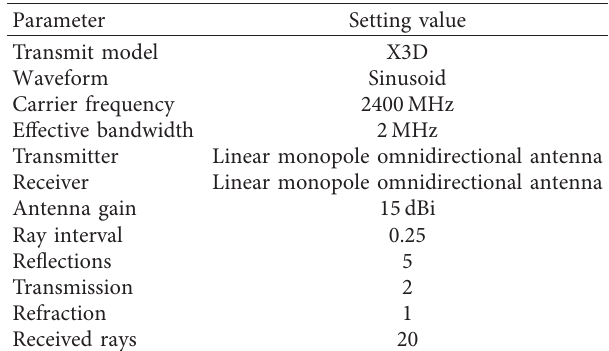
Figure 2: (a) Sketch of the ship structure “Zhaoming Wheel.” (b) The three-dimensional model of the ship cabin. (c) The second floor of the engine room. (d) The platform of the control Table 1: The simulation parameter.